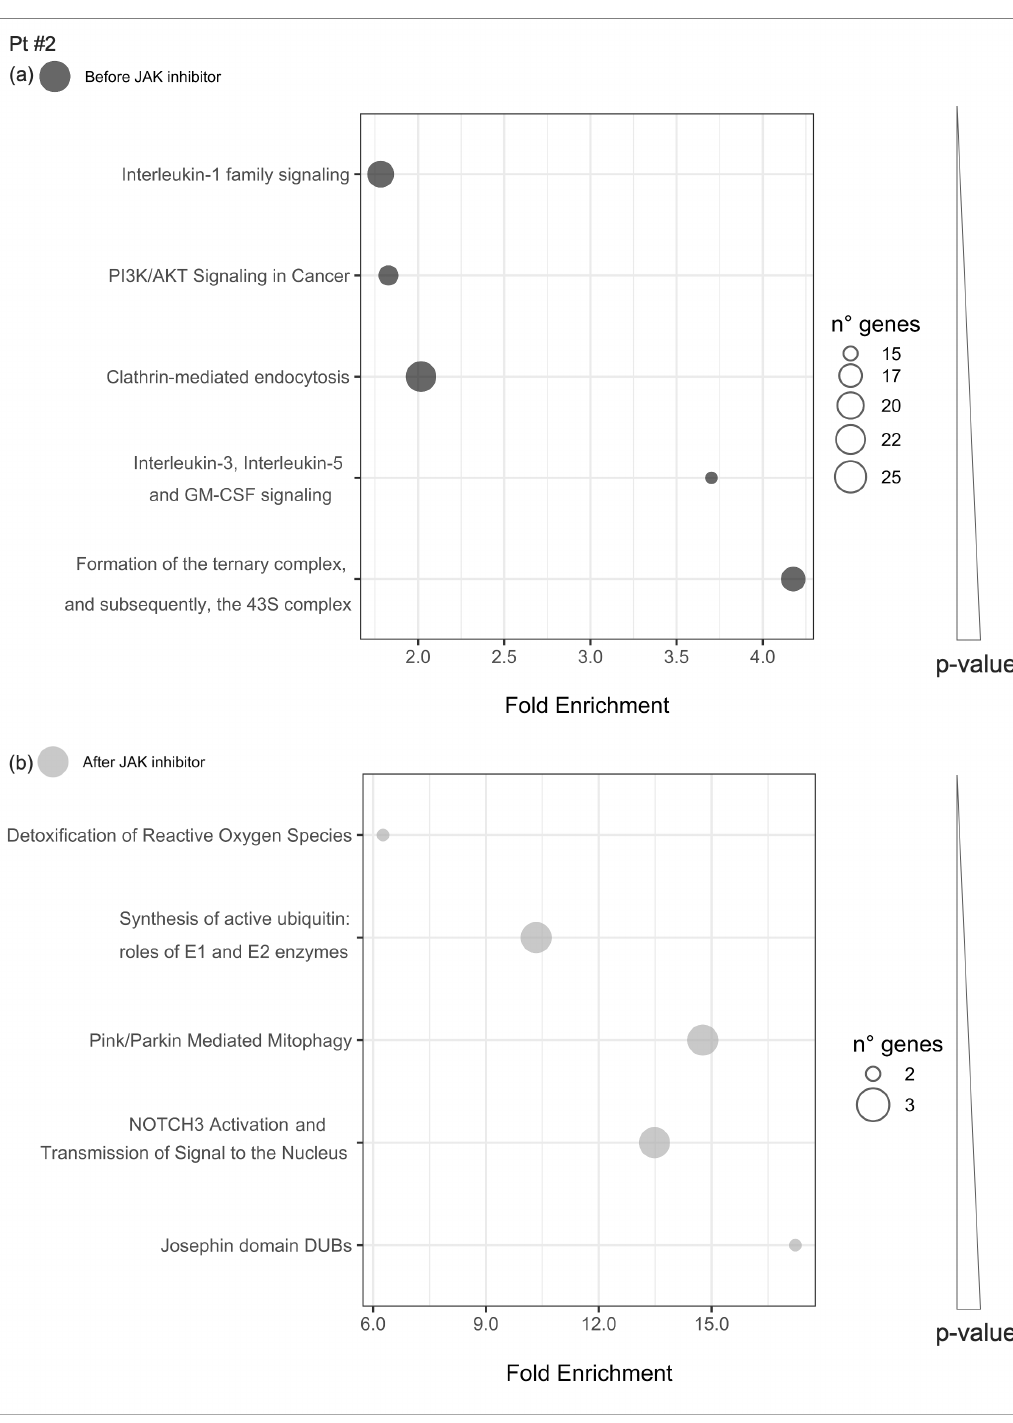
Figure 9. Pathway enrichment analysis was run on di ff erential expressed genes resulting from the comparison between patient #2 before JAKinhibs and the control-group subjects and between patient #2 after JAKinhibs and the controls. Pathways altered uniquely before ( a ) or uniquely after ( b ) JAKinhibs were chosen. Each dot represents a pathway, and the size is directly proportional to the number of genes. On the X -axis the pathway fold enrichment is displayed. All the selected pathways showed a lowest adjusted p -value of the given term over all iterations ≤ 0.01, and the five most enriched pathways were elected, where applicable. Pathways are ordered by increasing p -values. Pathways altered before JAKinhibs are colored in dark grey and those altered after JAKinhibs in light